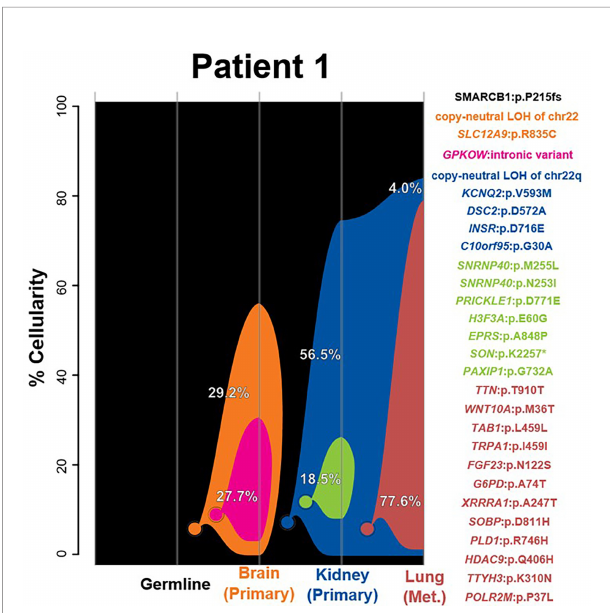
FIGURE 2 | River plots show the composition of clones in multiple tumor samples plus matched normal blood (germline) sample. Vertical lines indicate a sample, labeled on the X-axis. Colored circles indicate the origins of a clone from a single cell, either of the germline (black) or a preceding clone. Colored outlines show the cellularity of clones (Y-axis) in each sample. Percentages shown (in white or black text) indicate the cellularity of a tumor clone in each sample that was identi fi ed, excluding the cells of any descendant clones. Clone percentages sum to the total tumor cellularity of a sample. Samples are arranged to most clearly visualize clonal descent but do not represent a formal time-series. Copy number variants (CNVs), loss-of-heterozygosity events (LOH), and single nucleotide variants (SNVs) identi fi ed in the tumor samples, as well as relevant germline predisposition variants, are listed on the right and colored by which clone they belong